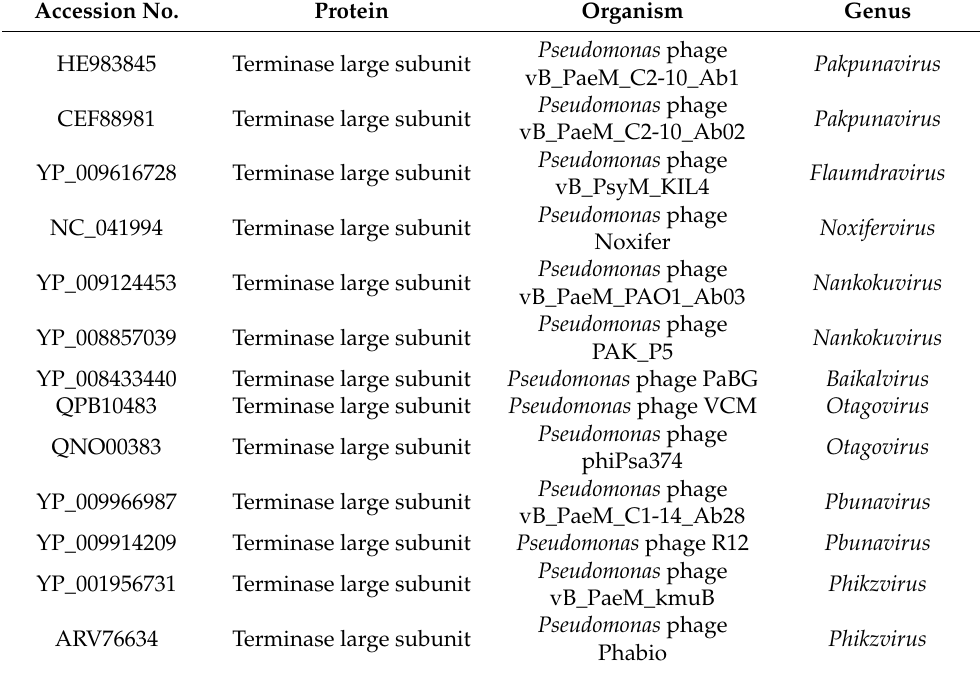
Table 1. Accession numbers of genes used in phylogenetic